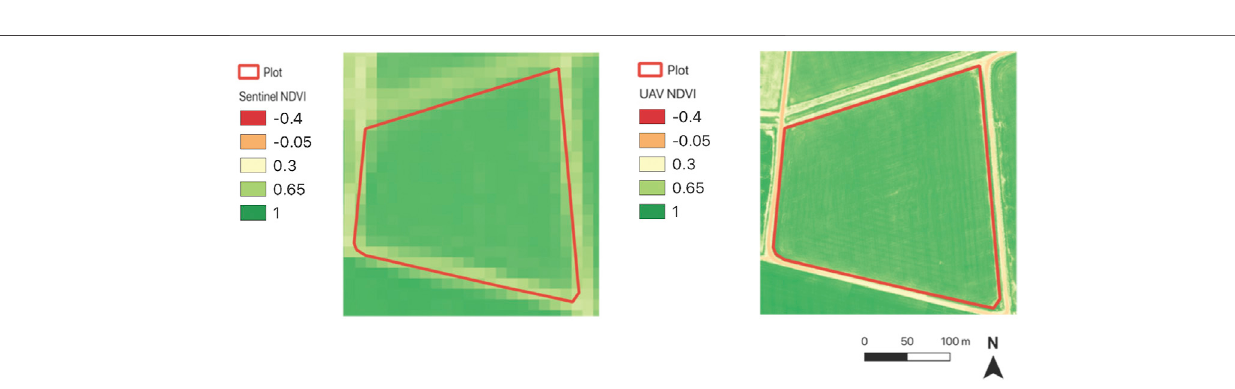
Frontiers in Remote Sensing |